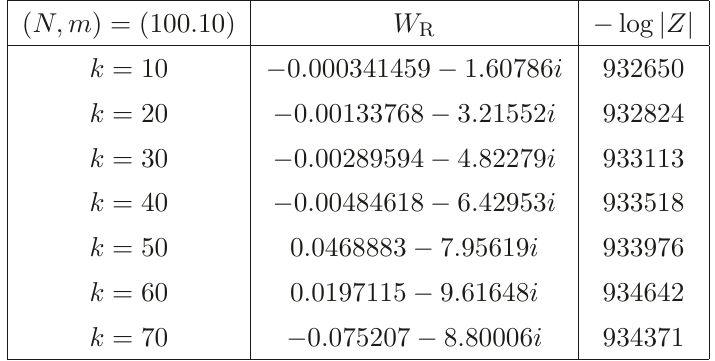
Table 4 . The value of Wilson loop and free energy corresponding to the confinement type saddle solution (3.30) from numerical